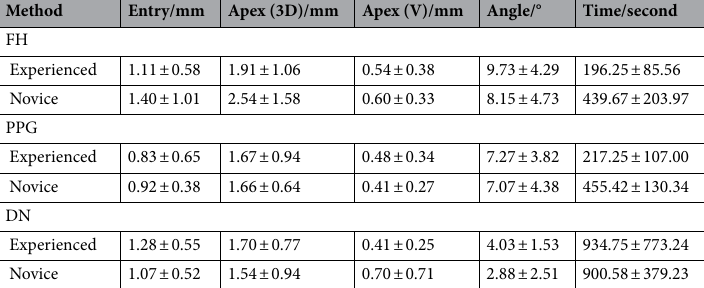
Table 1. Descriptive values (Mean ± SD) by surgery method and experience. FH freehand, PPG pilot drill based partial guidance, DN dynamic